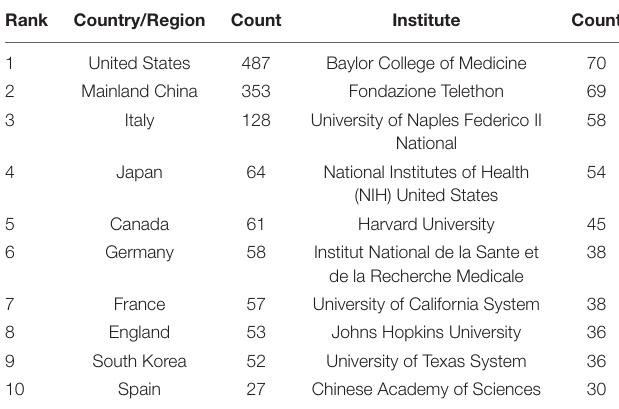
TABLE 1 | The top 10 journals that published articles in TFEB research. TABLE 3 | Top 10 countries and institutions in the number of publications.